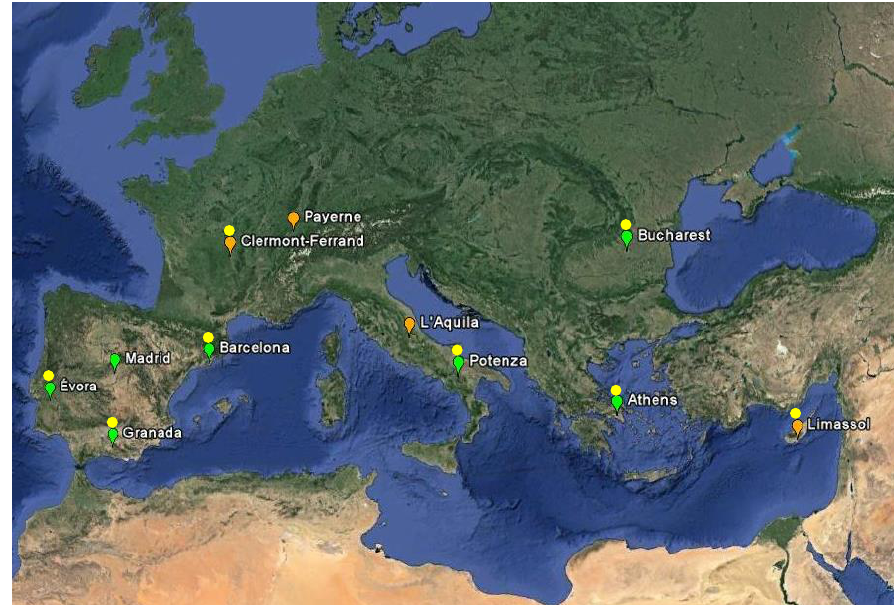
Figure 1. Geographical position of the 11 stations that participated in the exercise. Green labels indicate advanced lidar systems; orange labels indicate Raman lidar systems. Yellow circles indicate co-located sun photometers. Table 1. Wavelengths and temporal resolution, (cid:49)t , of the systems involved in the exercise. Station Elastic